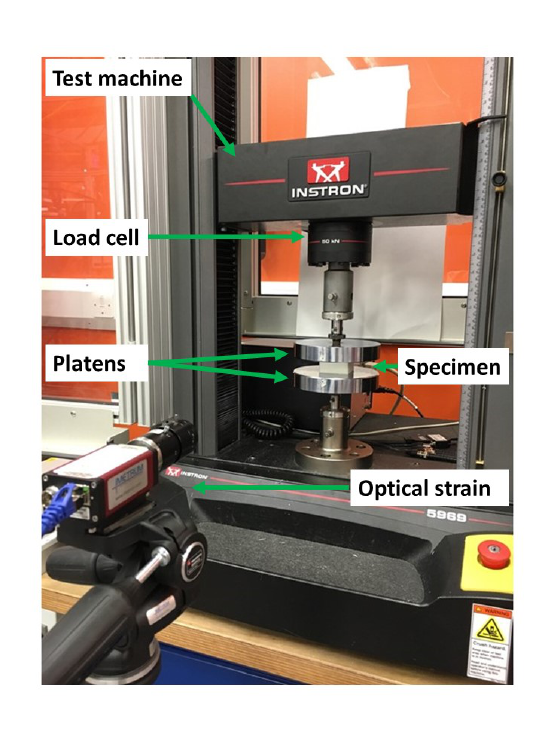
Figure 2. Quasi-static compression test